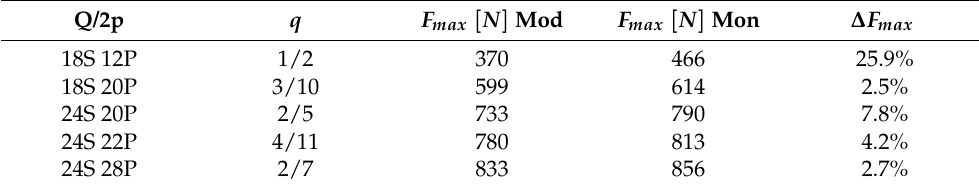
Table 5. Difference between the radial force on modular and monolithic machines in terms of the number of slots per pole per phase.